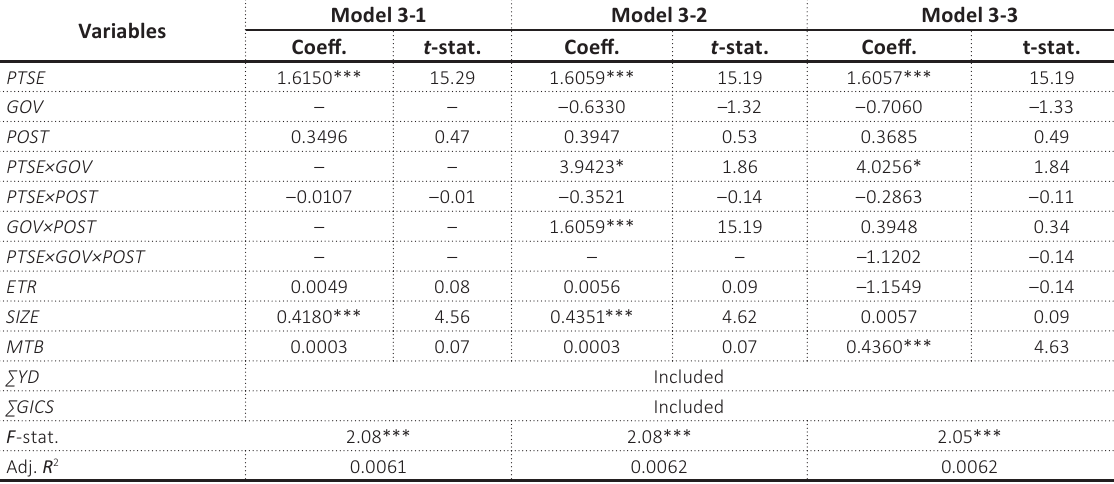
Table 6. Regression results: effects of governmental ownership and the global financial crisis on the realization of an implicit